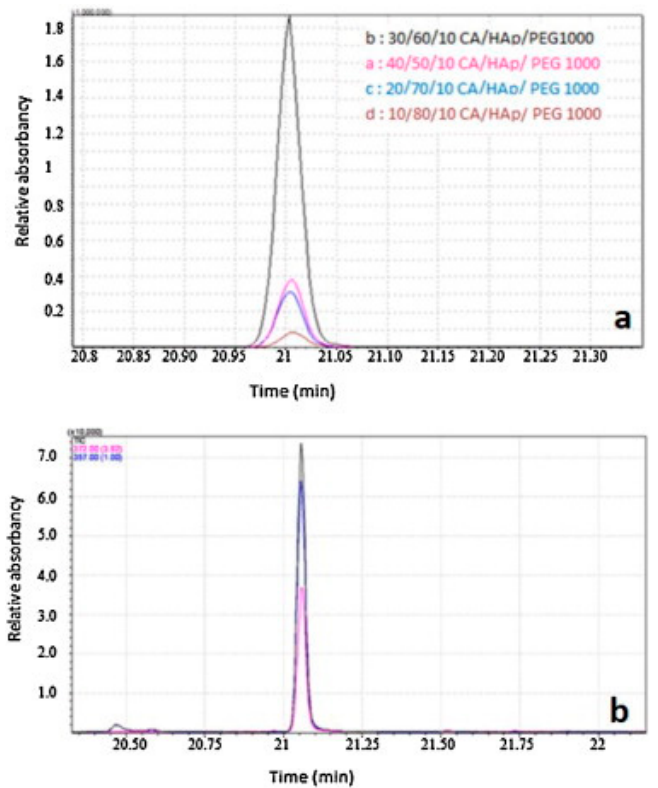
Figure 4. Chromatograms of bisphenol-A desorbed from cellulose acetate / hydroxyapatite / poly(ethylene Figure 4 . Chromatograms of bisphenol-A desorbed from cellulose glycol) (CA / HA / PEG) composite membranes ( a ) and commercial Florisil ( b ) (reproduced with acetate/hydroxyapatite/poly(ethylene glycol) (CA/HA/PEG) composite membranes ( a ) and permission from Ref. commercial Florisil ( b ) (reproduced with permission from Ref. [53]).